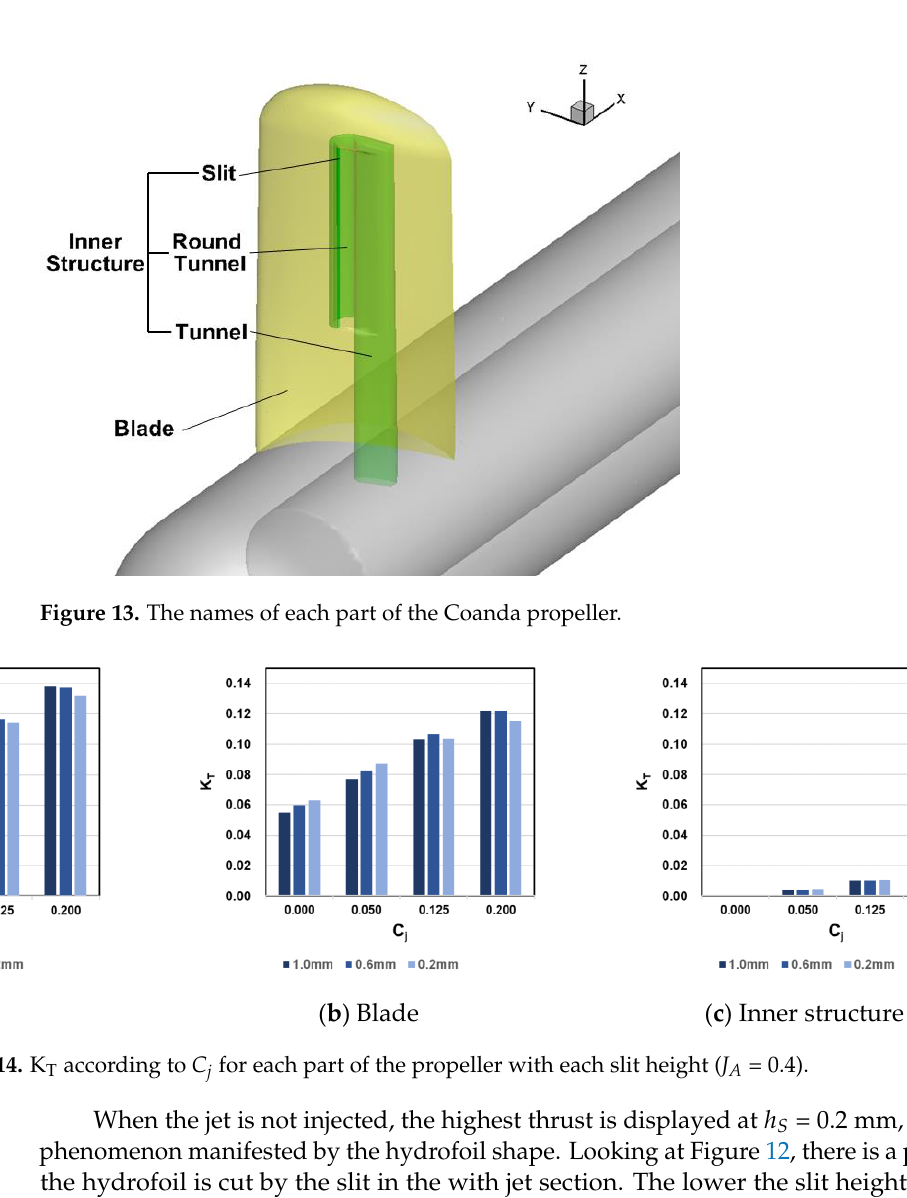
30.63 Figure 12. NACA66 (MOD, t/c = 0.24) geometry for each slit height. Figure 13 shows the names of each part of the Coanda propeller. The slit, round tun- nel, and tunnel are combined into an inner structure, and all the remaining parts of the